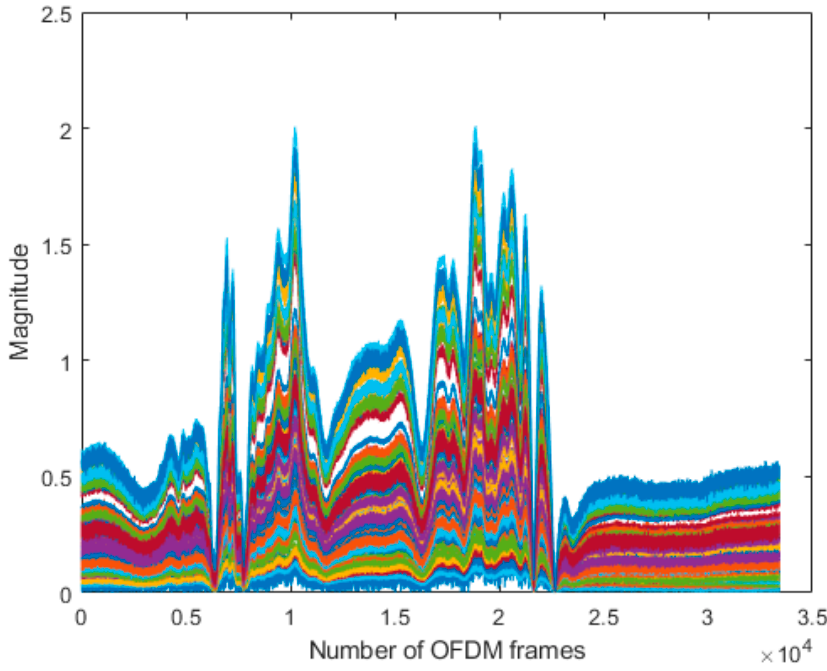
Figure 7. Result of correct activity using 64-subcarriers.